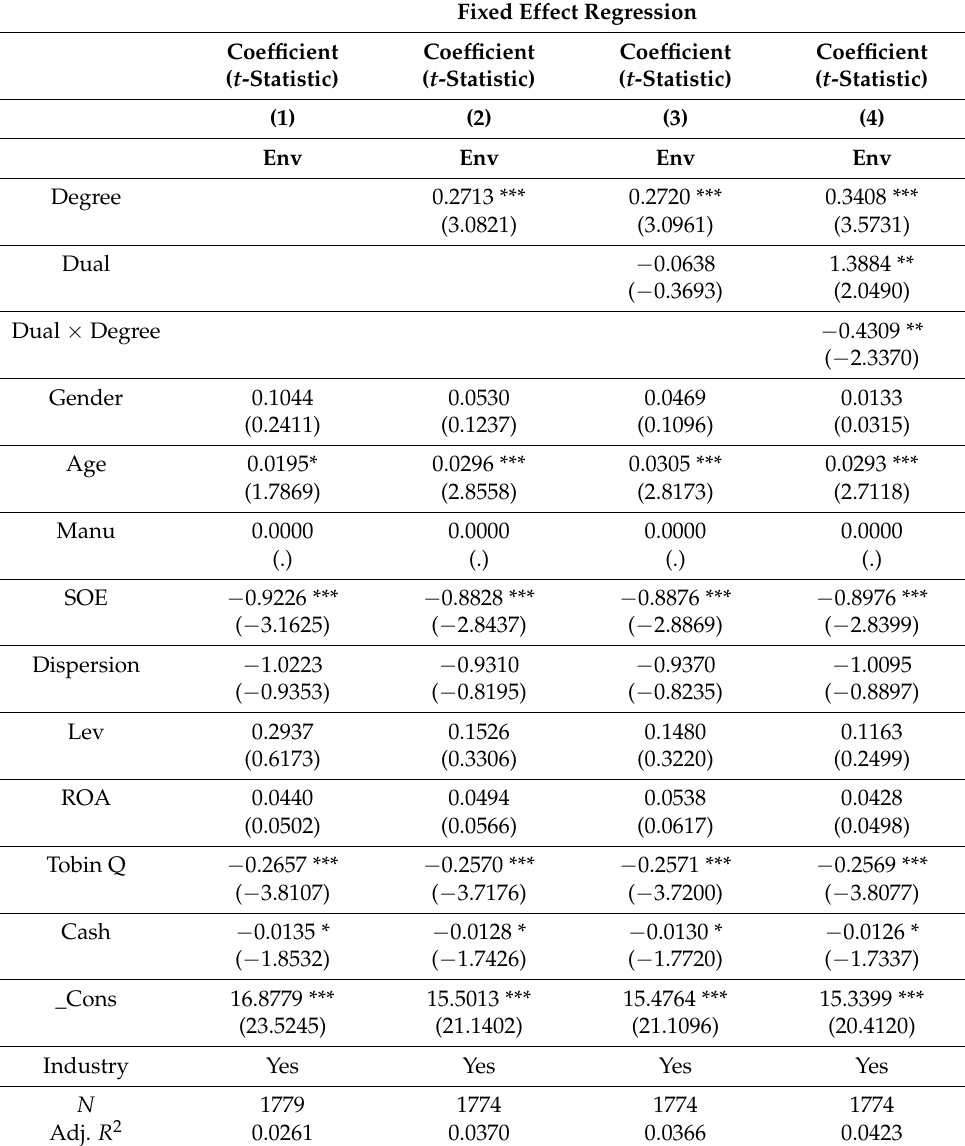
Table 4. Cont . Panel B: Regression Results for the Heavy Pollution